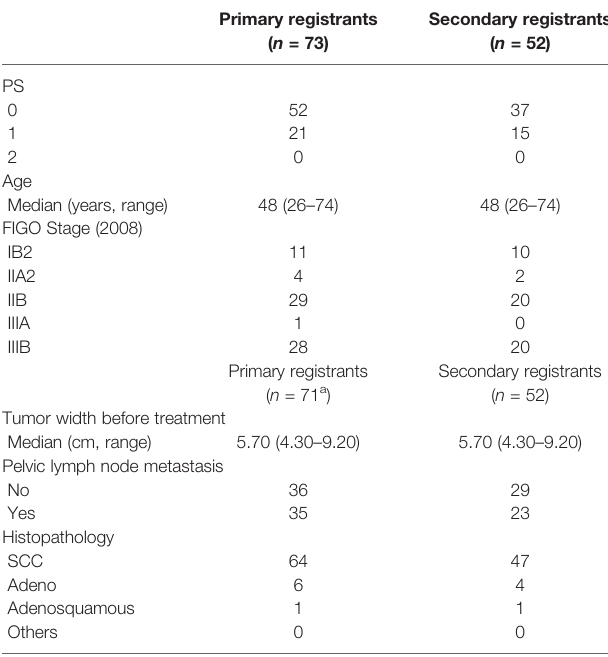
TABLE 2 | Characteristics of the patients recruited to the phase I/II trial.